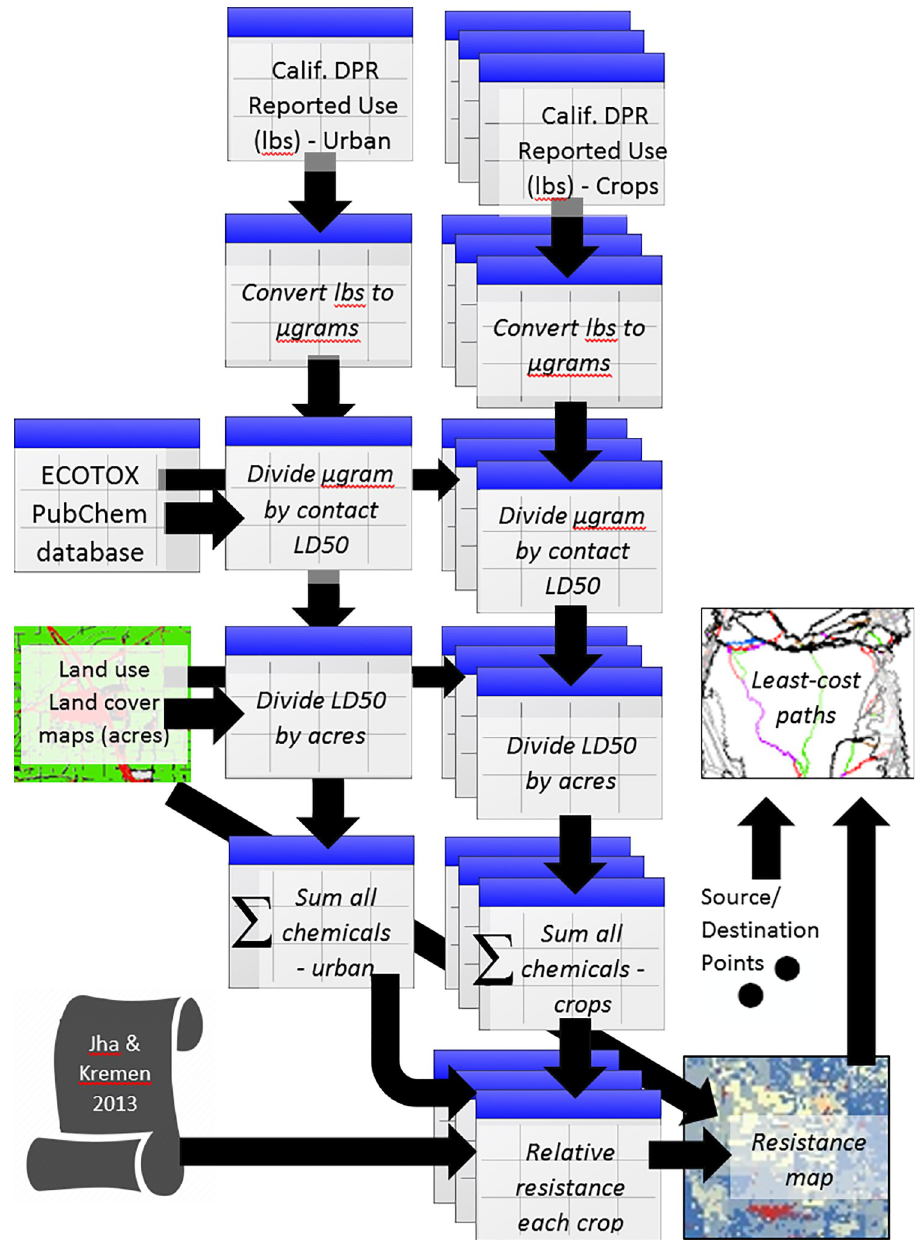
Fig 1. Workflow used to generate the least-cost paths. The five sources of input data include pesticide application reporting (State of California Department of Pesticide Regulation Pesticide Use Reporting database), toxicology databases (US Environmental Protection Agency ECOTOX database and the US National Institute of Health PubChem database), land cover maps (LandIQ crop map, NOAA Coastal Change Analysis Program, and US Geological Survey National Land Cover Map), estimates of landscape resistance for urban areas derived from Jha and Kremen (2013), and source and destination points created along the margins of the study area. Relative resistance of each crop/land cover type is shown in Table 1. Tabular data are depicted with the table icon whereas mapped data are shown using map icons. Italicized text indicates steps taken to process data. Non-italicized text is used to show input